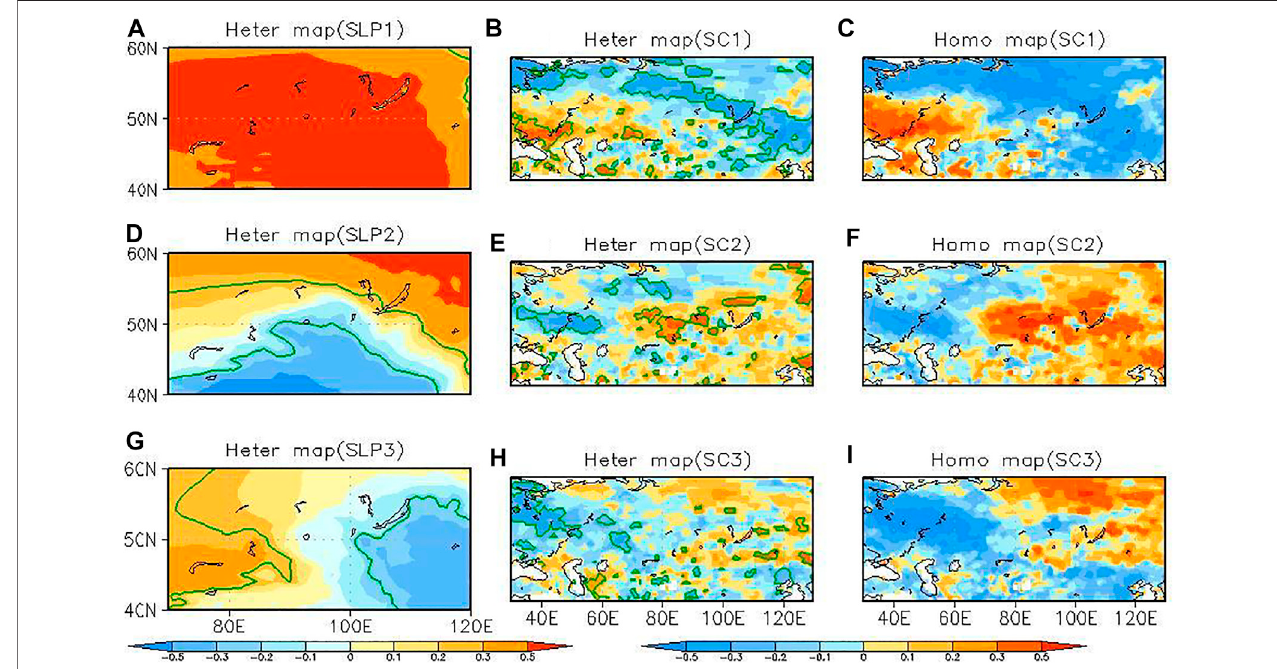
FIGURE6| Heterogeneouscorrelationcoef fi cientmapsofDJFSLP (A) ,ONsnowcover (B) ,andhomogeneousmapofONsnowcover (C) inthe fi rstSVDmodeof observations. (D – F) For the second SVD mode, (E – F) for the third SVD mode. The green line indicates the value signi fi cantly exceeding the 90% con fi dence level.